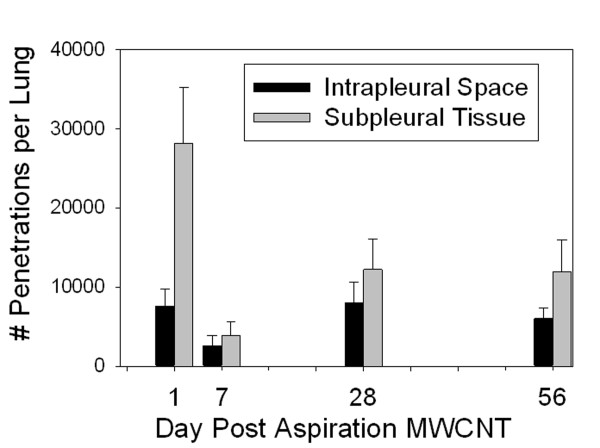
Time course of MWCNT penetrations into the subpleural tissue and intrapleural space. There was a significant number of penetrations into the subpleural tissue and intrapleural space with an initial spike at one day after aspiration with some initial clearance evident by the decline at 7 days. However the number of penetrations in both spaces significantly increased after day 7 and was still elevated 56 days after the initial aspiration. Data from animals given a single aspiration dose of 80 μg. As indicated by the asterisk, the number of subpleural tissue penetrations at 1 day was significantly different from the number of penetrations at 7, 28 and 56 days. (Mean ± SE, N = 8).